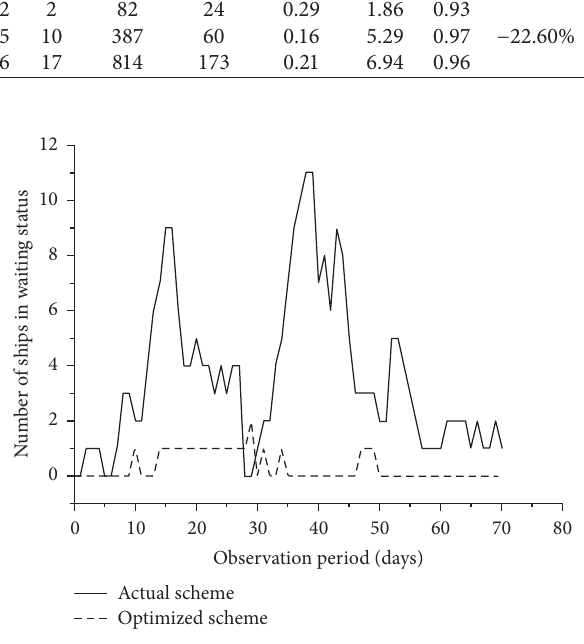
Figure 5: Comparative analysis of ships in waiting